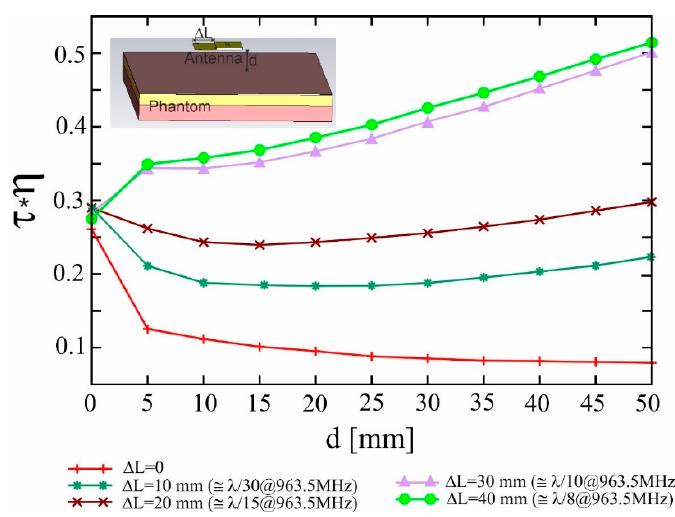
Figure 6. τ × η with respect to the distance from the body phantom for different extensions of the antenna ground plane.